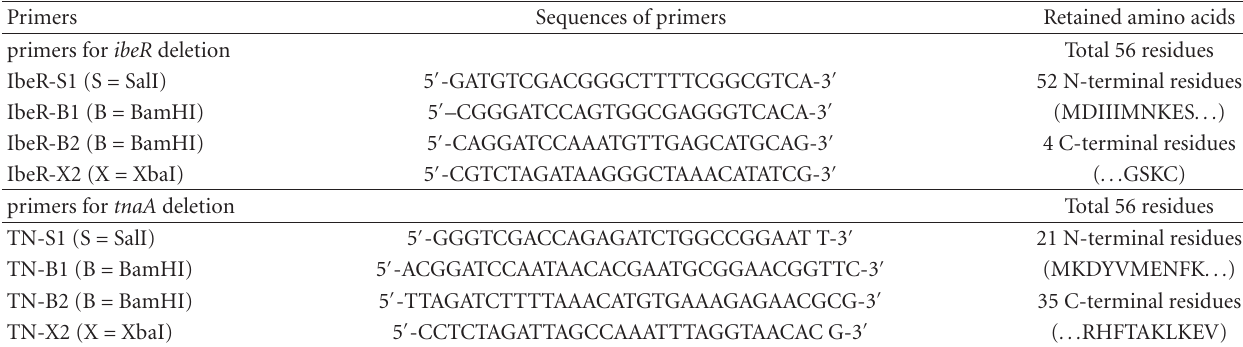
Table 2: Oligonucleotides used for cloning, sequencing, and making the deletion mutants of ibeR and tnaA